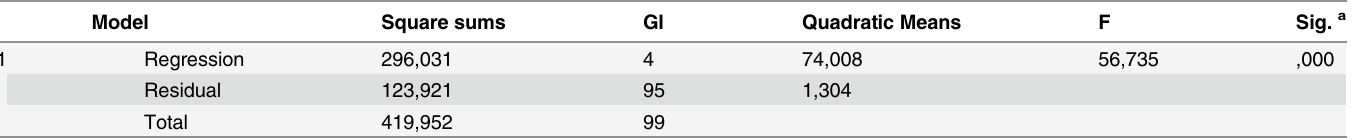
Table 5. Anova Test.